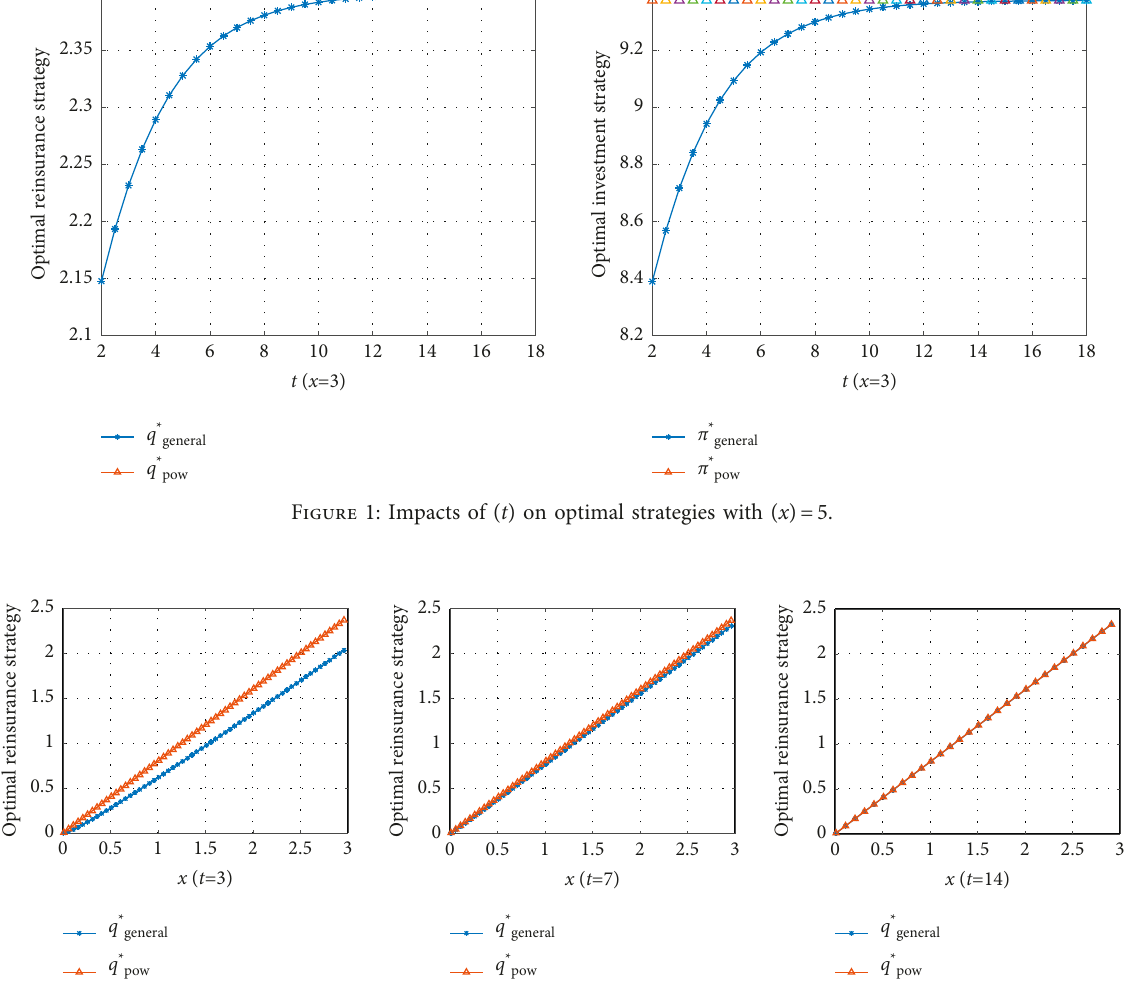
Figure 2: Impacts of ( x ) on optimal reinsurance strategies with different values of ( t ).